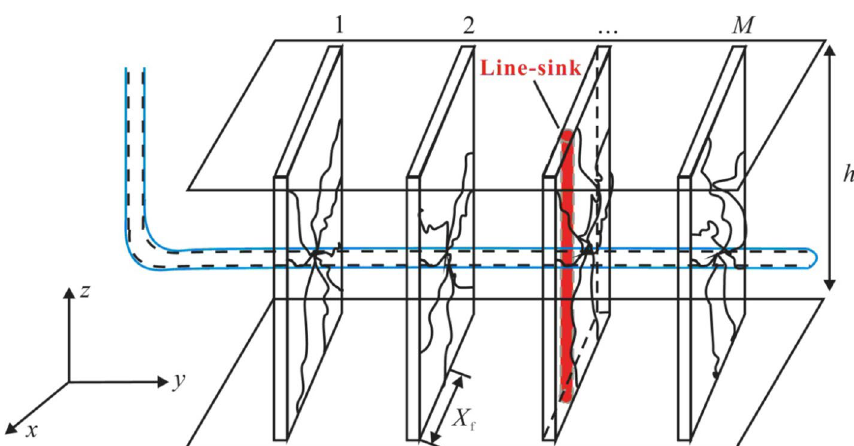
Fig. 2 Schematic of a multi- fractured horizontal well